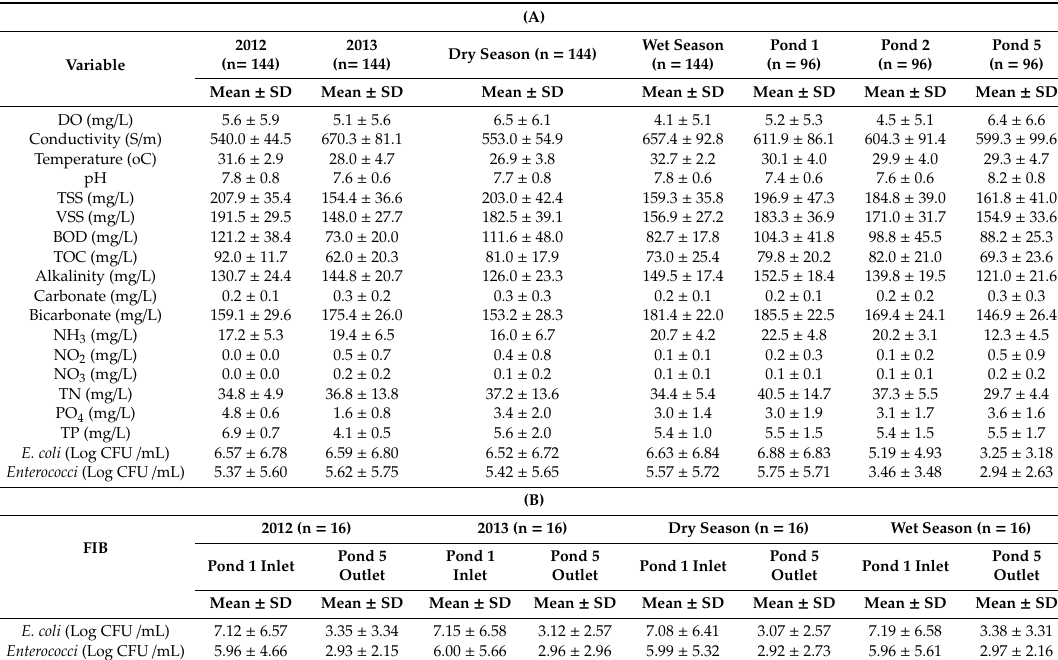
Table 2. Summary details for measured physicochemical variables and standard cultured fecal indicator bacteria (FIB) (averages and standard deviations (SDs)) for 2012 and 2013, the wet and dry season, and ponds 1, 2 and 5. A. Average wastewater stabilization ponds (WSP) physicochemical and FIB levels according to year, season and pond number. B. Average E. coli and Enterococci colony counts between the Pond 1 inlet and the Pond 5 outlet for 2012 and 2013 and the wet and dry seasons. n = sample number, SD = standard deviation, mg / L = milligrams per liter, S / m = siemens per meter, BOD = biological oxygen demand, TOC = total organic carbon, TSS = total suspended solids, VSS = total volatile solids, NH 3 = ammonia, NO 3 = nitrate, NO 3 nitrite, TN = nitrogen, PO 4 = orthophosphate, TP = total phosphorus, CFU = colony forming